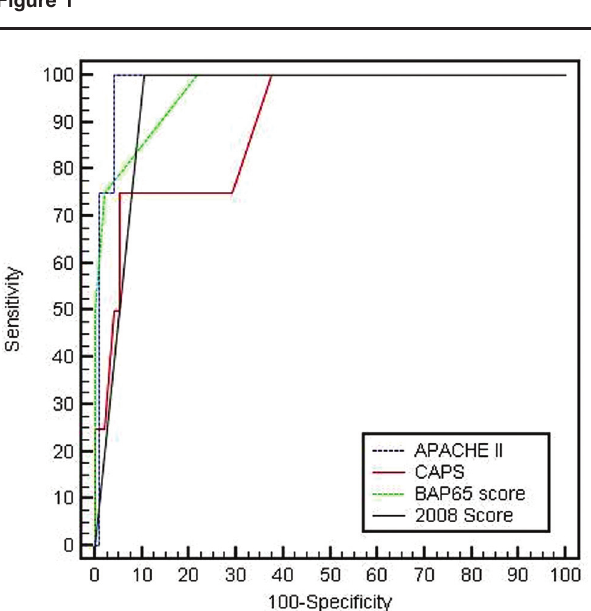
ROC curve for APACHE II, CAPS, BAP65, and 2008 scores to predict mortality. APACHE, Acute Physiology and Chronic Health Evalua- tion; BAP65, elevated blood urea nitrogen, altered mental status, pulse more than 109/min, age more than 65 years; CAPS, chronic obstructive pulmonary disease (COPD) and Asthma Physiology Score; ROC, receiver operating